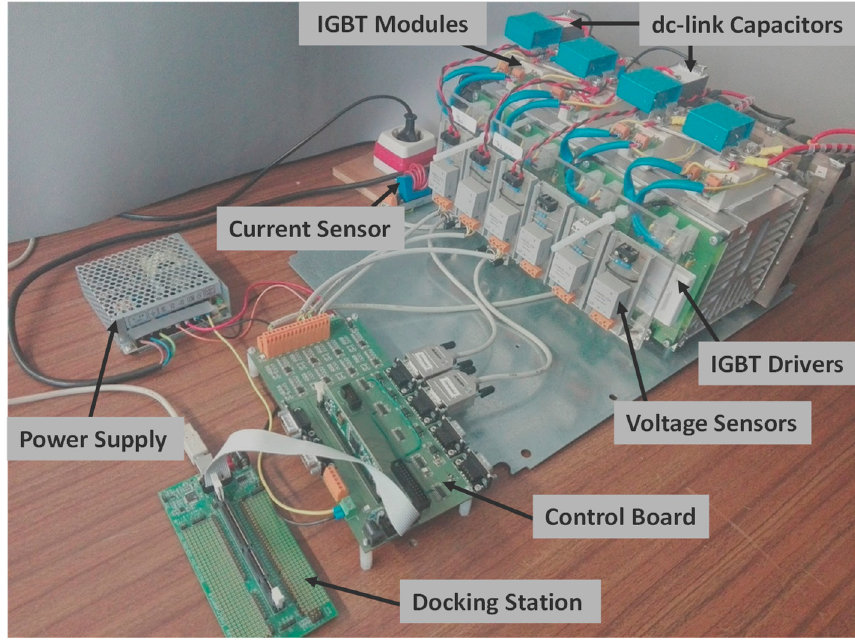
Figure 11. Developed laboratory prototype of the multilevel dc–dc power converter.